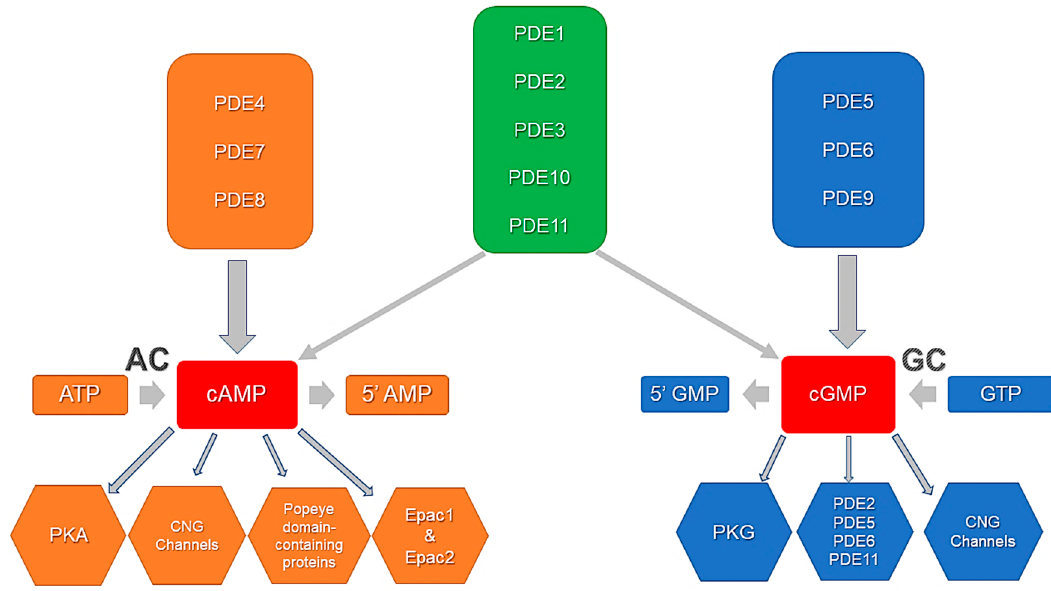
Figure 1. PDE activity, specificity, and cyclic nucleotide effector proteins. PDE4, PDE7, and PDE8 selectively degrade cAMP. PDE5, PDE6, and PDE9 selectively degrade cGMP. PDE1, PDE2, PDE3, PDE10, and PDE11 are dual-specificity phosphodiesterases that hydrolyze both cAMP and cGMP. Downstream effectors include PKA, PKG, Epacs, PDEs, CNG channels and Popeye domain-containing proteins. Adapted from Ahmad et al., 2015 [76].